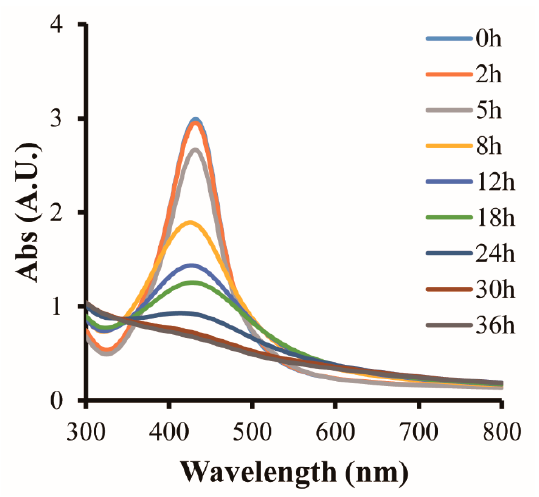
Figure 5. UV-Vis spectra of C-0.22Ag film after reaction with 2 ppm H 2 S.